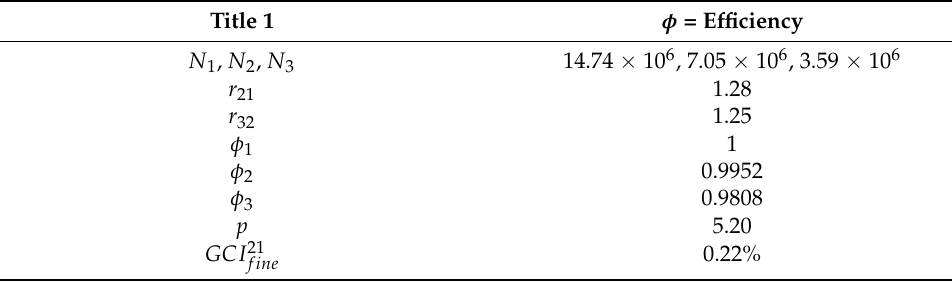
Figure 2. Numerical grids of the Francis turbine model. Table 2. Discretization error calculations for the Francis turbine model.